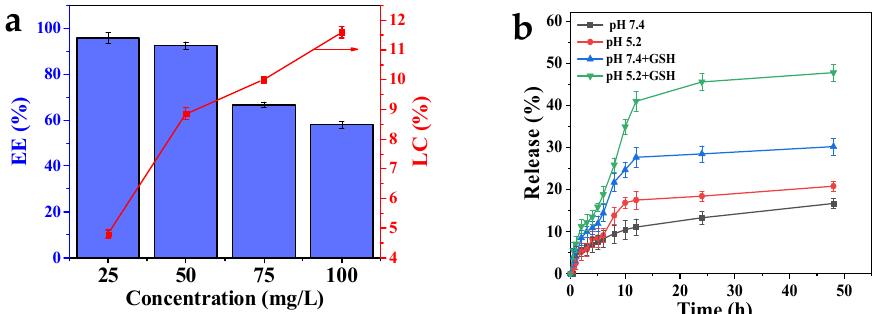
Figure 5. ( a ) DOX loading capacity (blue bar) and encapsulation efficiency (red broken line) of MPDA-DOX@FU-SS. ( b ) Release curves of MPDA-DOX@FU-SS at different pH values and in the presence or absence of glutathione (GSH) (n = 3).